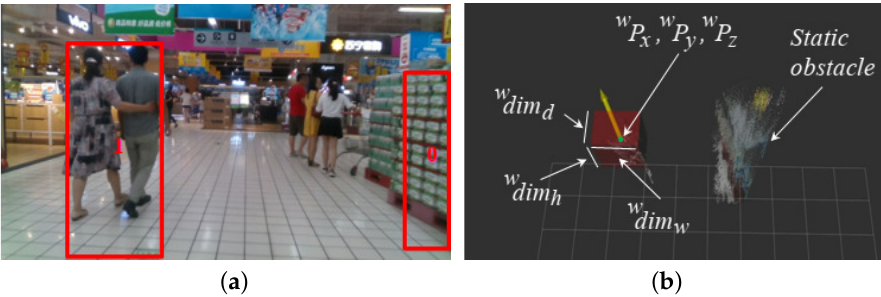
Figure 9. A sample magnified thresholded restricted v-depth map with a segmented obstacle within a bounding box.